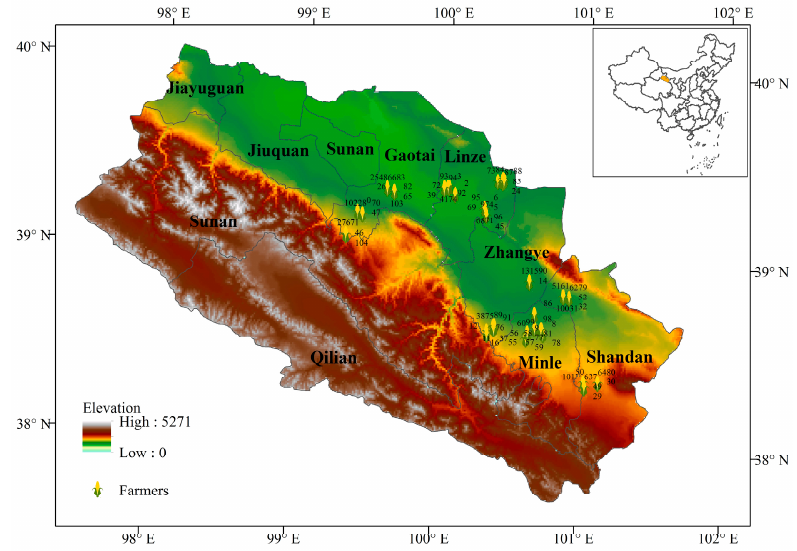
Figure 1. The administrative counties in the middle reaches of Heihe River Basin and the geographical distribution of our samples.